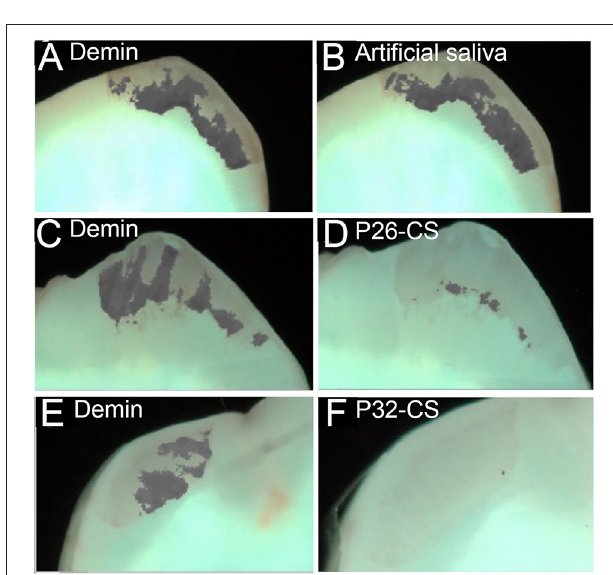
FIGURE 3 | Representative white-light images of the visual comparisons made between the three experimental groups tested. Demineralized samples (A, C, E) and remineralized samples (B, D, F) . The images clearly show a minimal visual decrease in the gray areas in the control remineralized in artificial saliva only (B) , whereas there is visual decrease in the gray patches (mineral gain) of the enamel sections post remineralization with P26-CS (D) and P32-CS (F) .